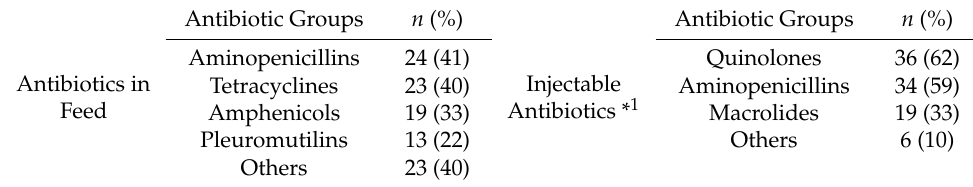
Table 5. Most cited antibiotic groups by pig